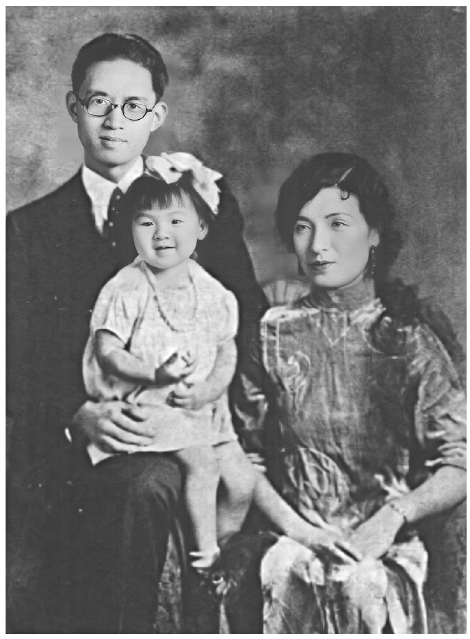
Figure 3. In 1932, Chi-Nan Hu, Chu-Chen Yu and their daughter (Lao S (1998) A Female general born on the other side of the ocean: Feipei Hu. Qingdao: Qingdao Publishing